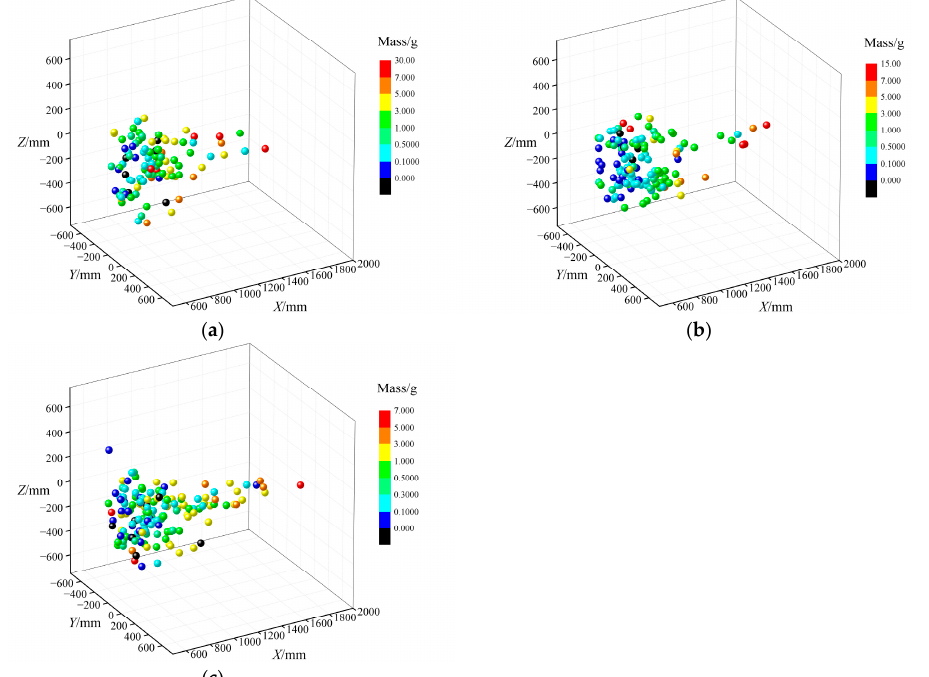
Figure 7. Three-dimensional distribution of the striking area of BAD. ( a ) L / D = 1.66 ( b ) L / D = 2.4 ( c ) L / D = 3.86.